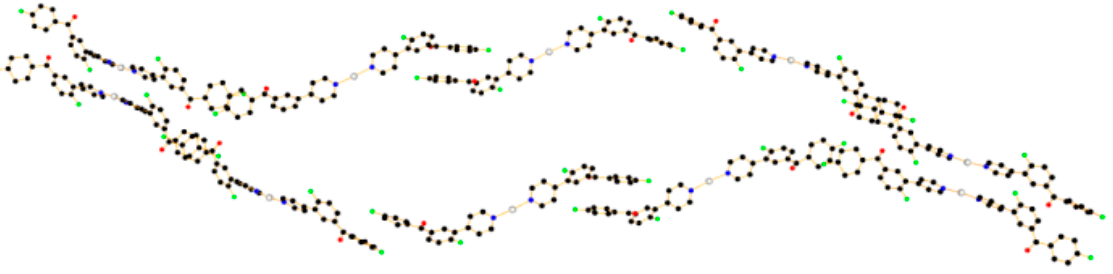
Figure 4. View of the dimer structure of complex 4a , hydrogen atoms are omitted for clarity (#1 = 0.5 + x , − 0.5 − y , − 0.5 + z ).